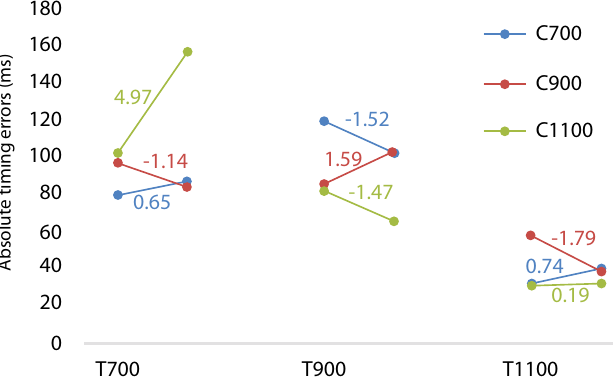
Figure 9 . Adaptation rates and regression slopes in relative and abso- lute timing measures in Constant 700 ms test (T700), Constant 900 ms test (T900) and Constant 1.100 ms test